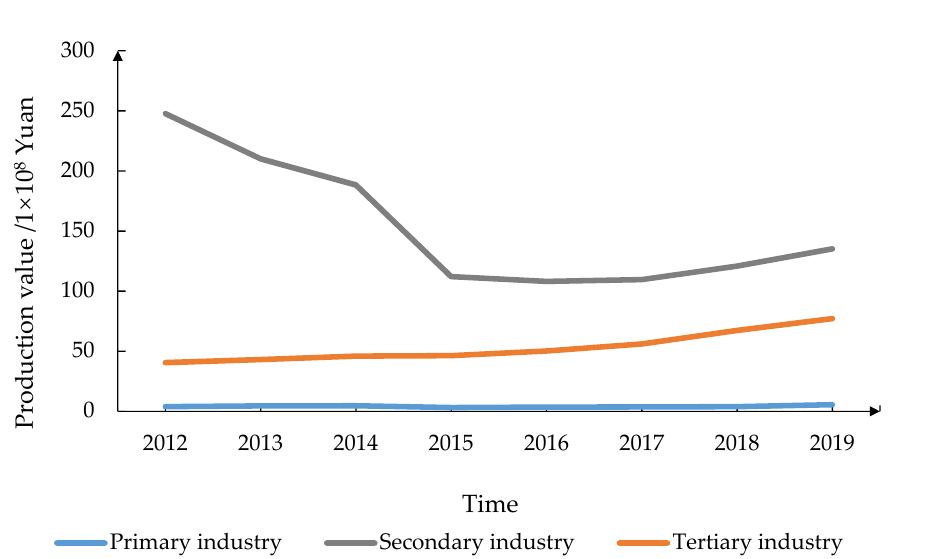
Figure 6. The changes in the industrial structure of Pinglu from 2012 to 2019. (The data were compiled from the Shanxi Statistical Yearbook from 2013 to 2020, and this figure shows the changing trend of the proportion of the output value of the three major industries in the total output value, which was made by Shufei Wang.)